Question: Provide a one-line summary of what is displayed.
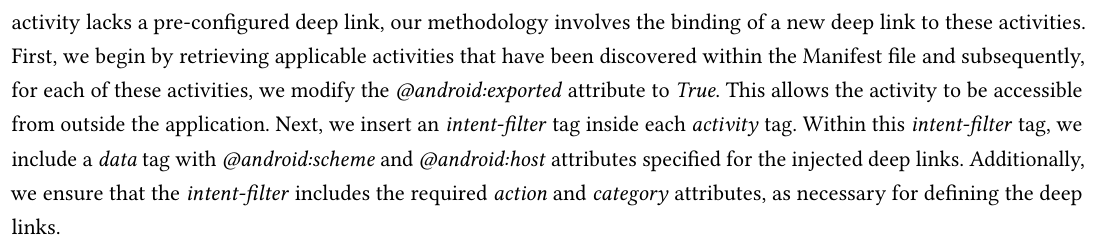
Answer: presents a process of deep link extraction and binding in the app ‘Amazon Prime Video’. Developers of